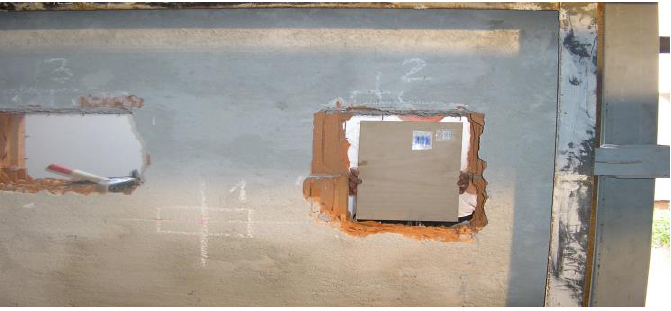
Figure 2. Breaking test of masonry made of ceramic blocks [18].